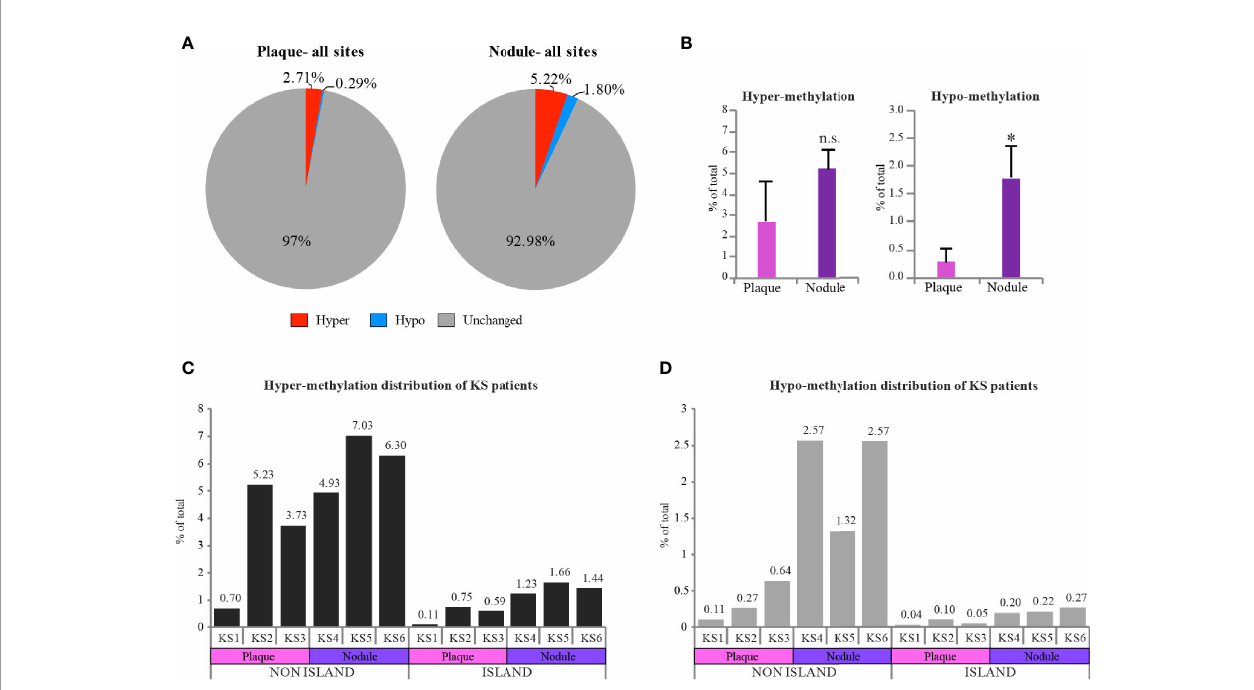
FIGURE 2 | Hypo-methylation increases as KS progresses from plaque to nodule. (A) Pie charts represent the percentage of hyper and hypo-methylated CpGs relative to control skin in two different stages of disease (Nodule and Plaque). (B) Column charts represent hyper and hypo-methylation distribution of Plaque vs. Nodule compared to control (represented as mean of three samples +SD). (C, D) Column charts represent hyper and hypo-methylation distribution of KS samples compared to control in CpG island vs. non CpG island regions. Percentage of each individual sample is indicated above each column. Hyper and hypo-methylation threshold was set as Db ≥ 0.25 and Db ≤ -0.25 respectively. Two-tailed T-tests were performed. *p < 0.05; n.s., not signi fi cant.